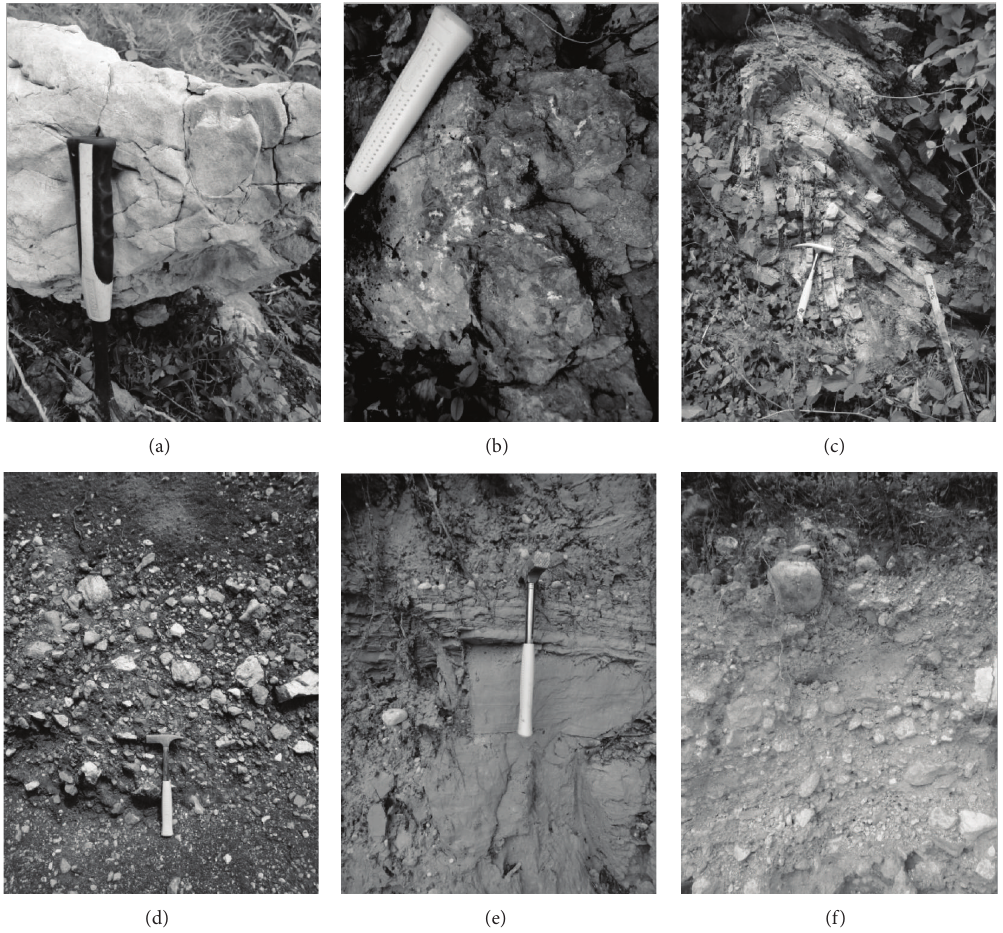
Figure 2: Typical lithologies according to the engineering-geological mapping: (a) Megalodontidae shell in Dachstein limestone in Robiˇc, (b) limestone breccia interbedded with shalestone near Robidiˇsˇce, (c) folds in flyschoid formation near Borjana, (d) heterogeneous composition of diamicton in Sedlo, (e) lacustrine chalk SW of Podbela, and (f) proluvium in